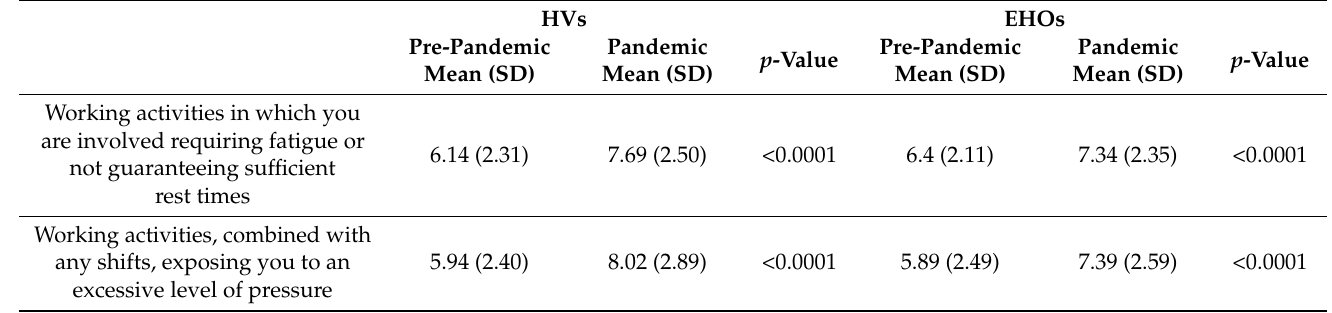
Table 4. Fatigue and pressure perceived by HVs and EHOs in pre-pandemic and pandemic